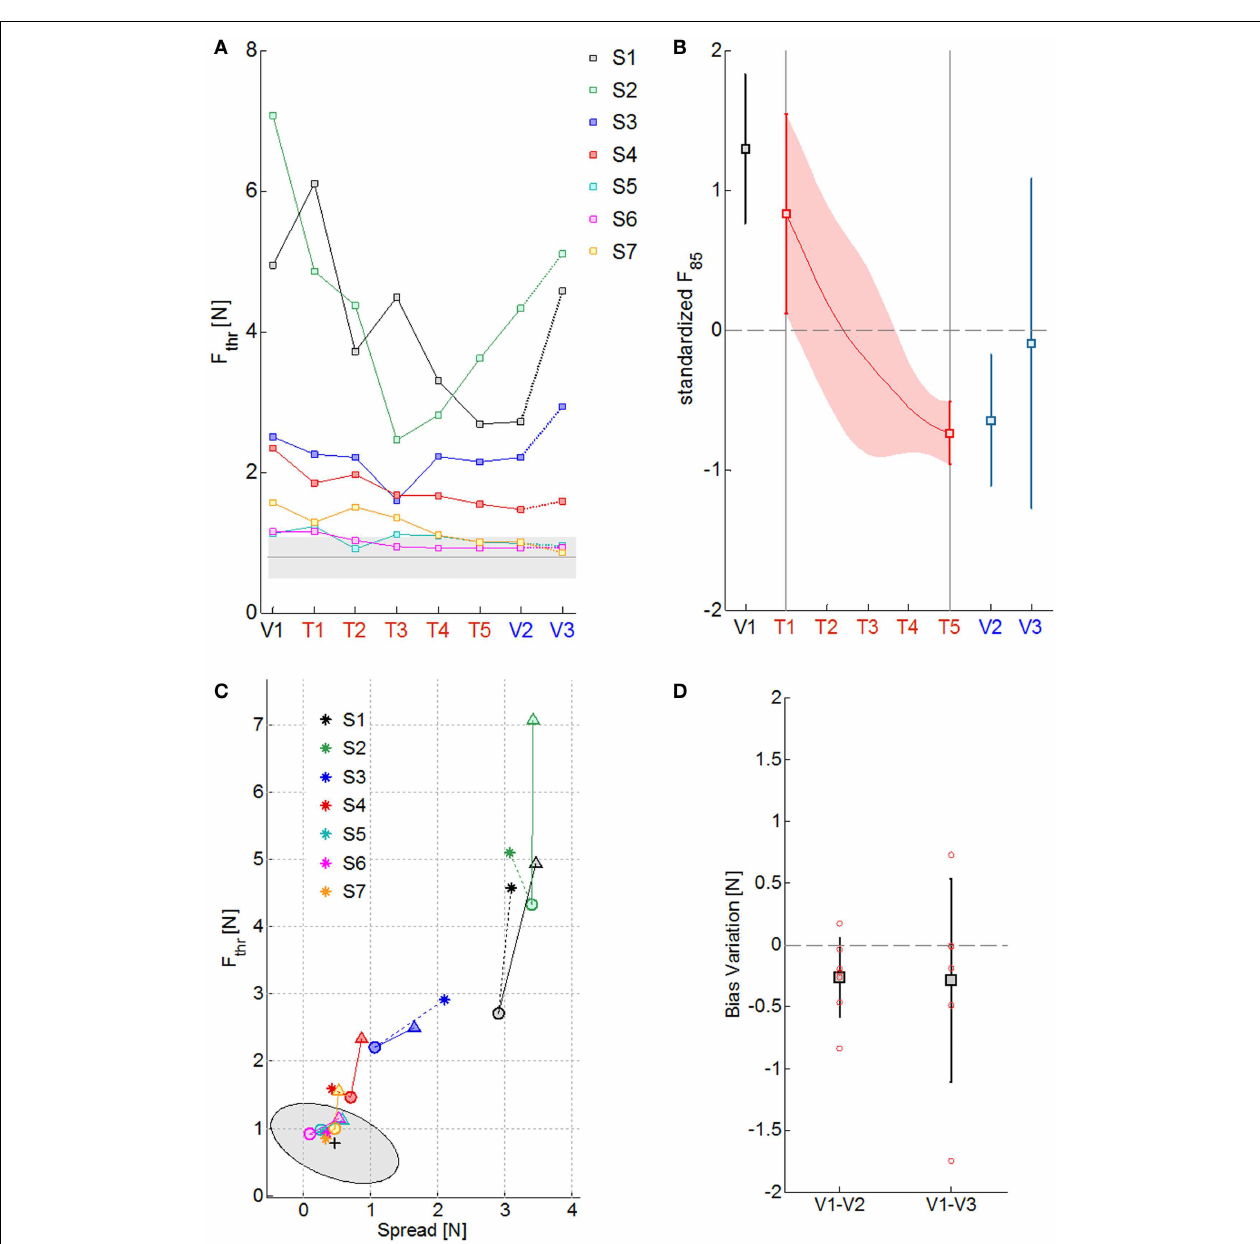
and asterisks indicate measures obtained respectively atV1,V2, andV3; colors represent different subjects; the mean performance of healthy control subjects is rendered by the black cross and the gray ellipse region represents the ellipse of variation along the principal components of the distribution. (D) Variation in the absolute value of the Bias level from the first to the final evaluation session (V1–V2) and to the follow-up evaluation session (V1–V3): squares stand for the mean variation, the total length of the error bars represent two standard deviations; single subject data are represented by the red